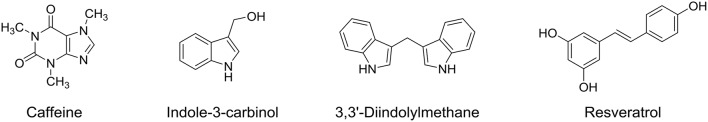
Selected plant derived natural products with paramount health promoting activity.